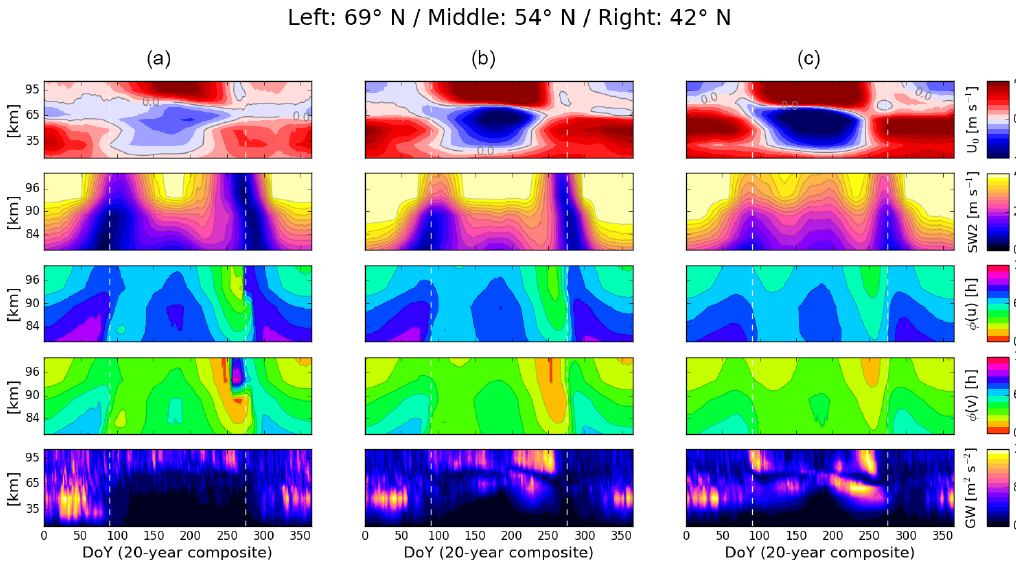
Figure 5. HAMMONIA composites of the simulated mean zonal ( U 0 ) wind, the migrating semidiurnal solar (SW2) tide, SW2 phases in the zonal ( φ(u) ) and meridional ( φ(v) ) components, and gravity wave kinetic energy over (column a ) Andenes, (column b ) Juliusruh and (column c ) Tavistock. The vertical white dashed lines indicate DoYs 90 and 275. Notice the different height range in the case of U 0 and the